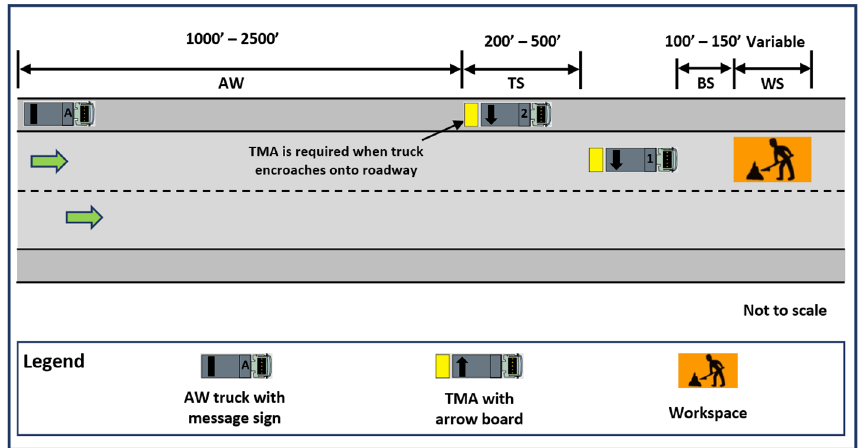
Figure 3. Recommended minimum requirements for a left lane closure [14].